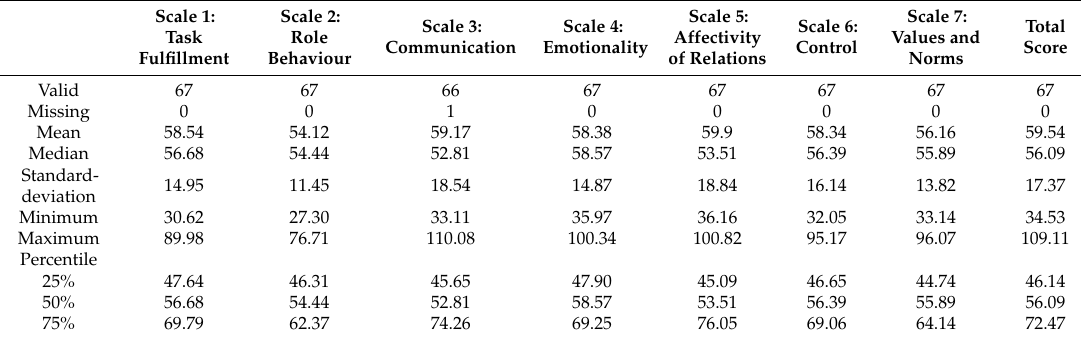
Table 1. Values of the